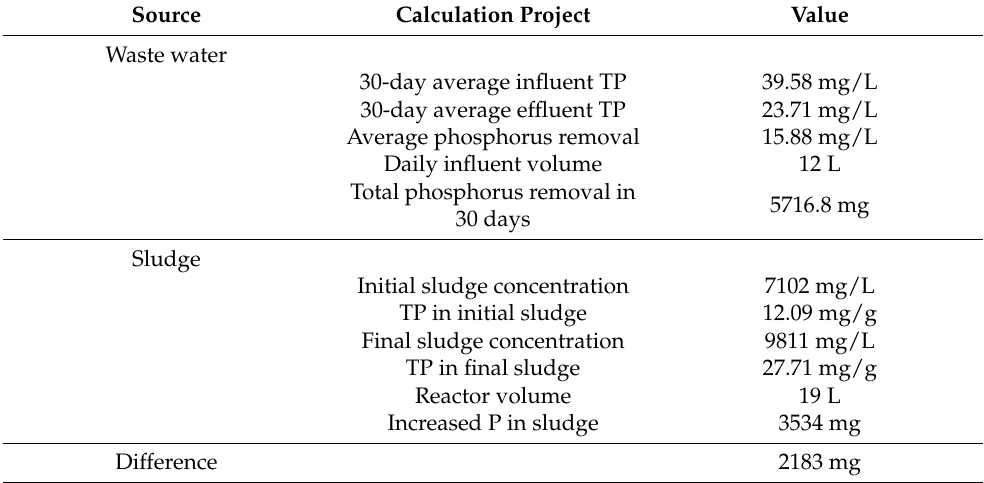
Table 2. Calculation of phosphorus balance in sewage and